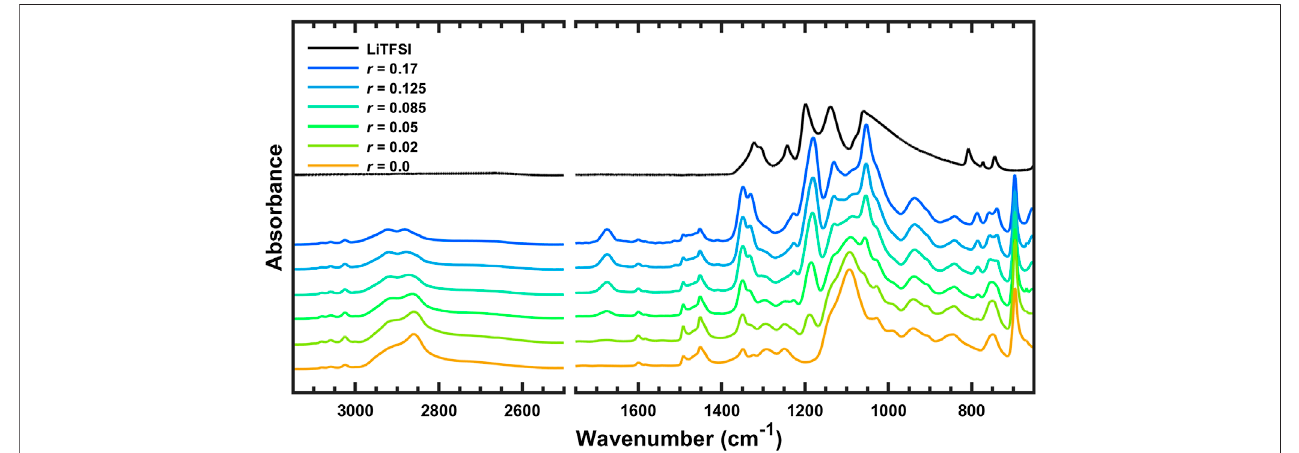
FIGURE 1 | FTIR spectra of SEO, LiTFSI, and SEO/LiTFSI polymer electrolytes with different salt concentrations at 120 ° C. For clarity, spectra have been vertically shifted, and regions that are not of interest have been omitted: 4,000 – 3,150 and 2,500 – 1,750 cm − 1 .